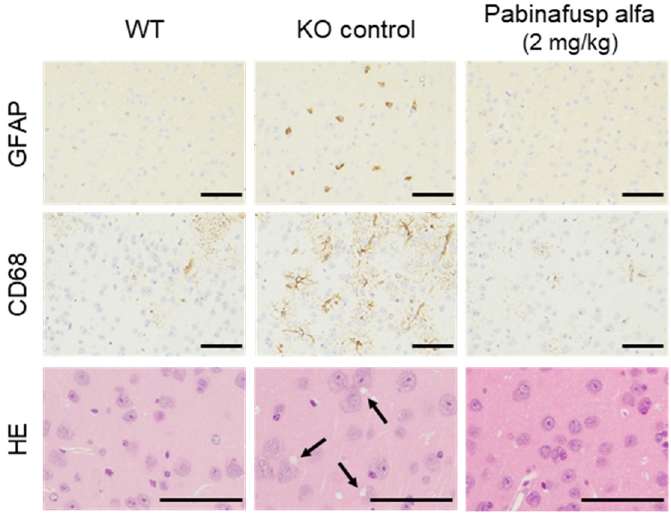
Figure 3. Prevention of neuroinflammation and neurodegeneration by pabinafusp alfa in MPS II mouse brains. Specimens from the brain cortex were stained with GFAP ( top ), CD68 ( middle ), and hematoxylin/eosin ( bottom ). Data are from a 36-week study. Arrows indicate the vacuolation of neuronal cells. Scale bars, 50 μ m. Updated from [20].